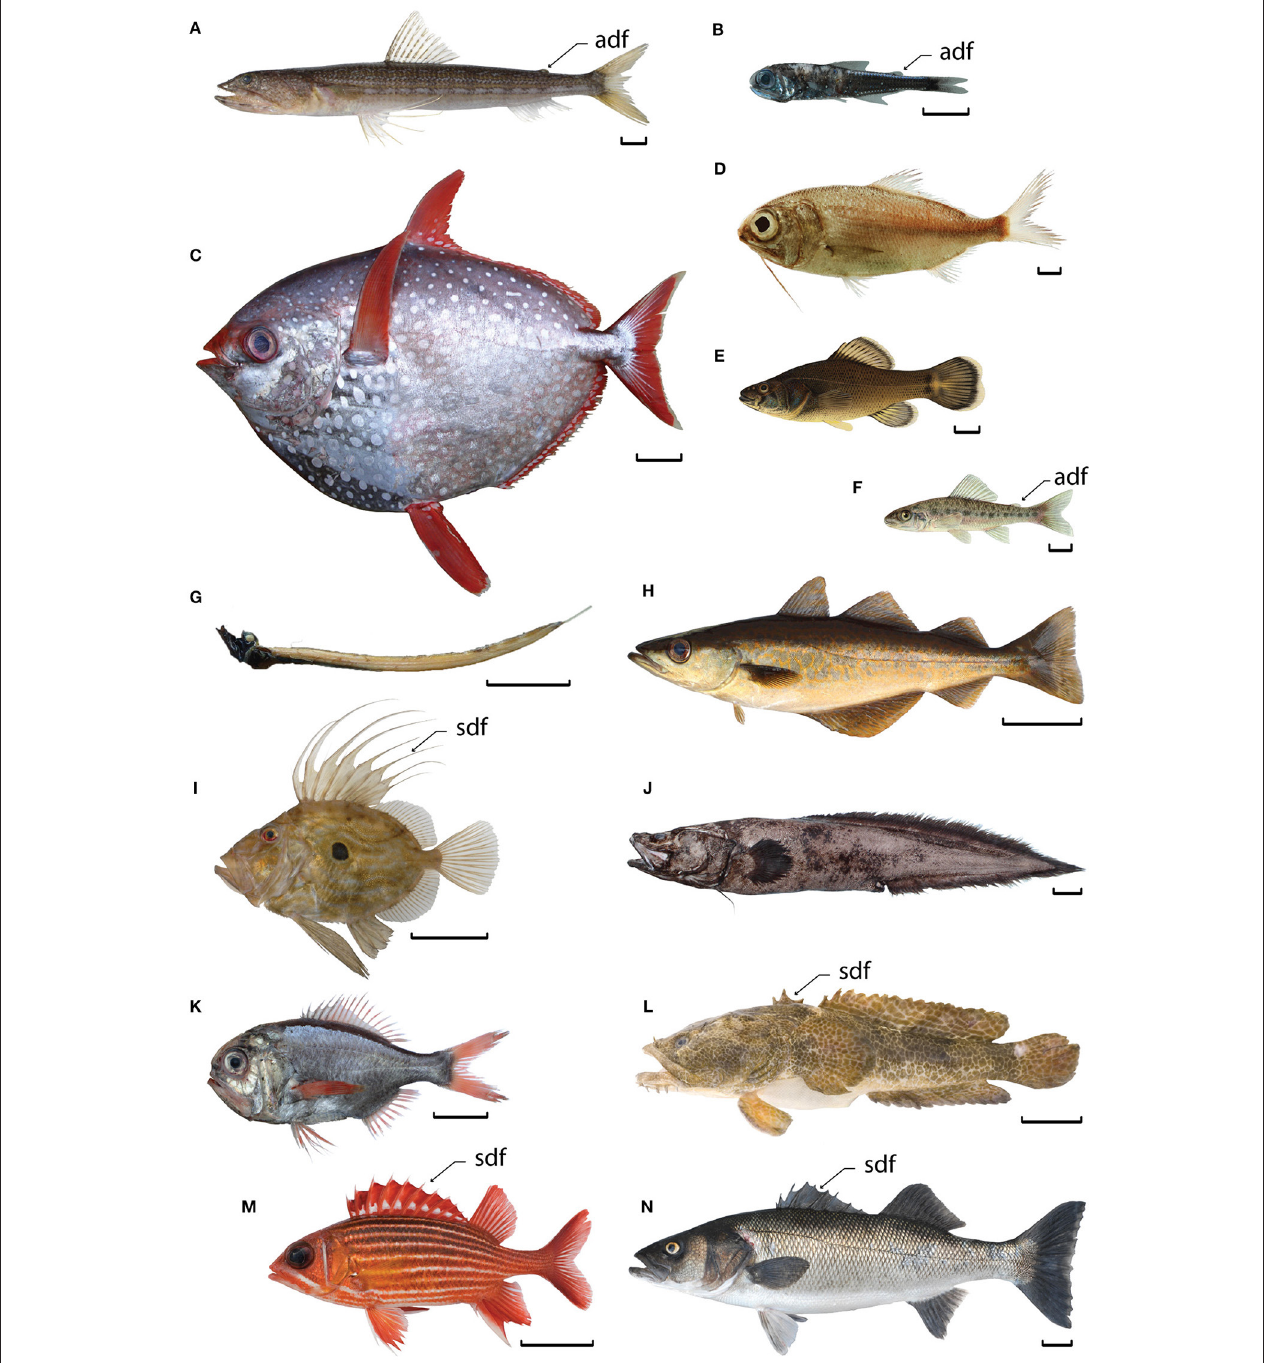
FIGURE 2 | Examples of species from the taxa studied. (A) Aulopiformes, Synodus saurus , MNHN/SBMC uncataloged. (B) Myctophiformes, Myctophum punctatum , MNHN/SBMC uncataloged. (C) Lampridiformes, Lampris guttatus , SBMC 2004-0006. (D) Polymixiiformes, Polymixia lowei , NOAA uncataloged. (E) Percopsiformes, Aphredoderus sayanus , painting. (F) Percopsiformes, Percopsis omiscomaycus , painting. (G) Stylephoriformes, Stylephorus chordatus , MNHN.IC.2004-1316. (H) Gadiformes, Pollachius pollachius , MNHN/SBMC uncataloged. (I) Zeiformes, Zeus faber , MNHN/SBMC uncataloged. (J) Ophidiiformes, Cataetyx laticeps , MNHN/SBMC uncataloged. (K) Beryciformes, Hoplostethus mediterraneus , MNHN/SBMC uncataloged. (L) Batrachoidiformes, Halobatrachus didactylus , MNHN/SBMC uncataloged. (M) Beryciformes, Sargocentron hastatum , MNHN 2013-0848. (N) Percomorpha, Dicentrarchus labrax , MNHN/SBMC uncataloged. Abbreviations: adf, adipose fin; sdf, spinous first dorsal fin. Scale bar equals 10 mm (A,B , D–F) , 50 mm (G–N) , 100 mm (C) . Sizes are based on specimen measurements, or on the “common length” measure given in FishBase (D-F). Photos D. Davesne (G), courtesy of Iglésias (2014) (A,B, H–N) , NOAA (D) and Wikimedia Commons (D,E)